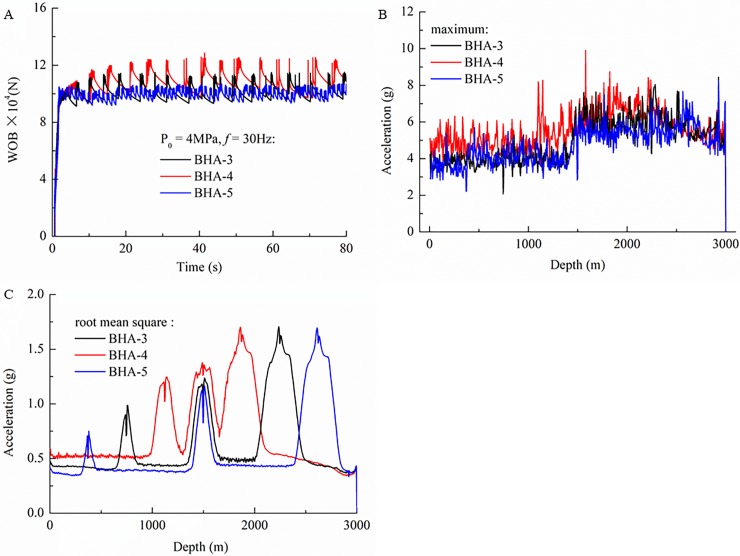
Effect of installation distance of shakers on weight on bit and accelerations of the drill-string.(A) Change of weight on bit in the bottom hole over time. (B) Maximum acceleration along the drill-string. (C) Root mean square acceleration along the drill-string. https://dx.doi.org/10.17504/protocols.io.kfactie.